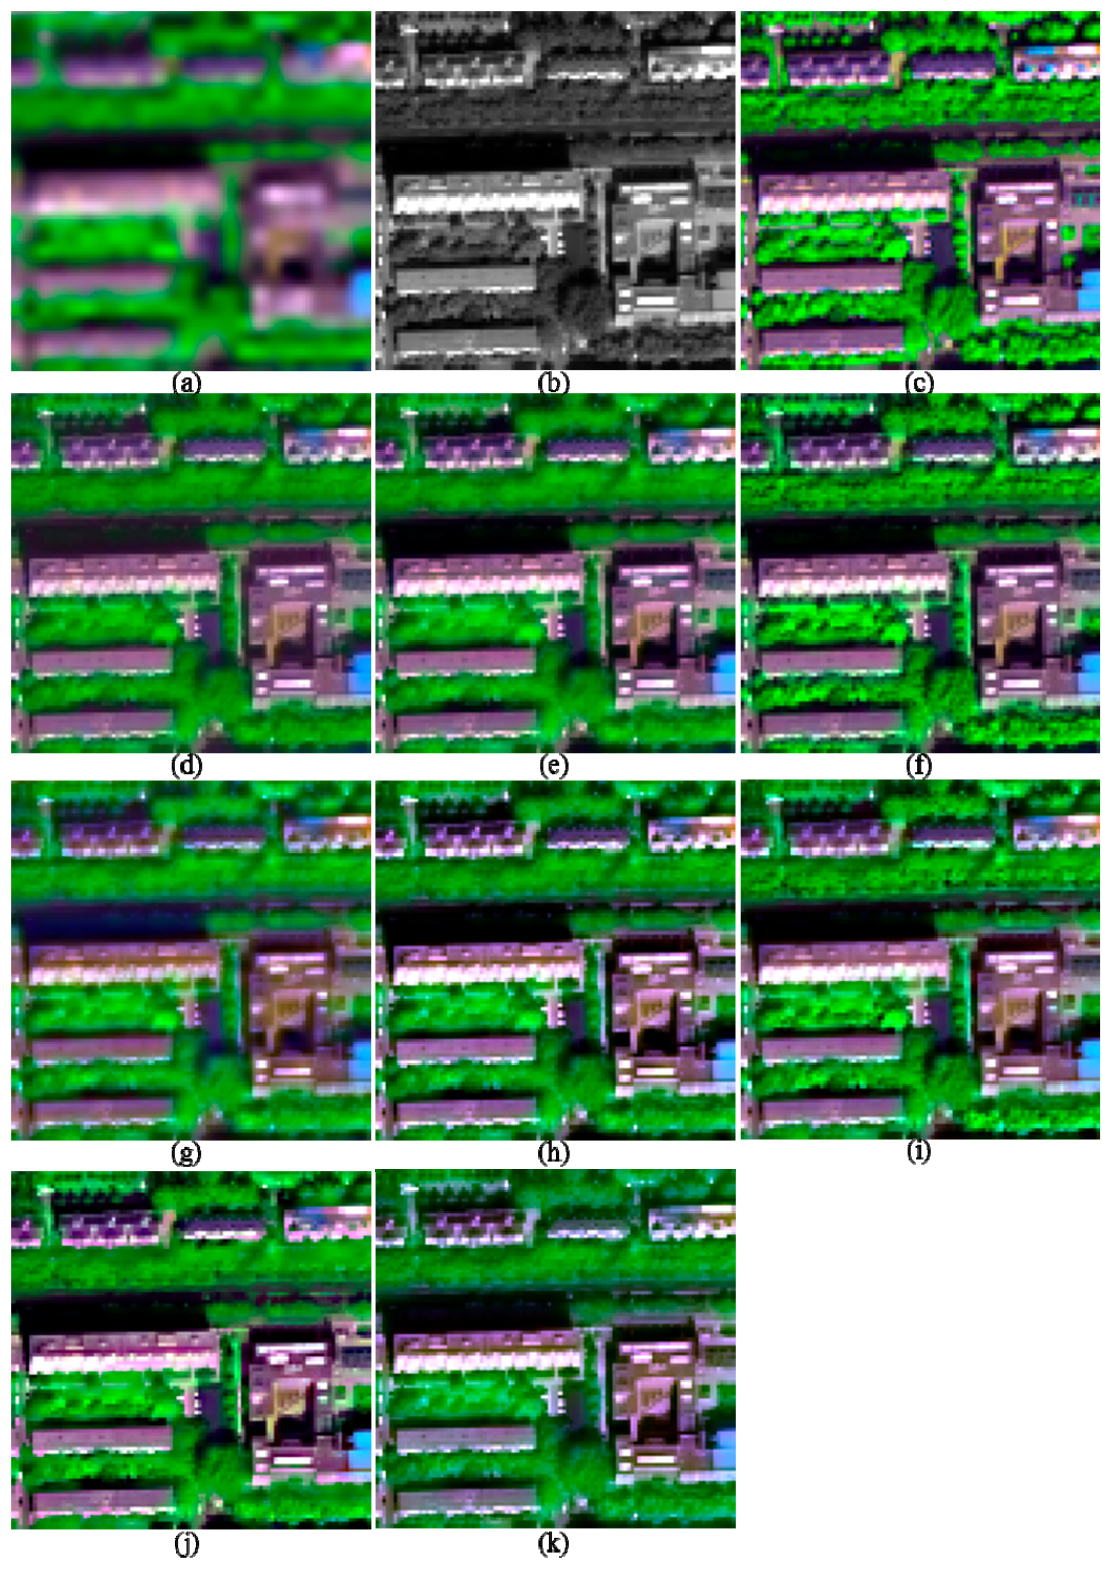
Figure 4. The degraded and 2-m fused images of I2, shown in band 5-7-2 composition. ( a ) 8-m MS; ( b ) 2-m PAN; ( c ) True 2-m MS; ( d ) GS; ( e ) GSA; ( f ) HR; ( g ) HCS; ( h ) ATWT; ( i ) GLP_ESDM; ( j ) GLP_ECBD; and ( k ) NSCT_M2.